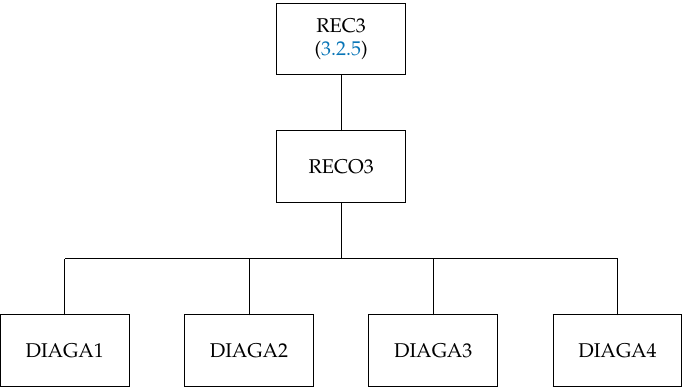
Figure 11. Structure of the subroutine REC3